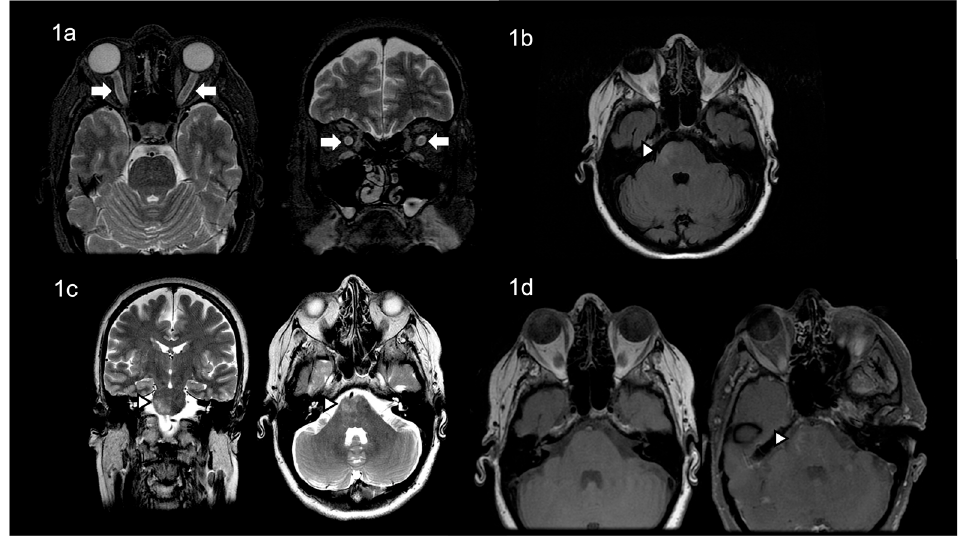
Figure 1. The patient’s brain MRI revealed, in T2 images, ( a ) mild thickening of the bilateral optic nerves, and ( b , c ) high-intensity lesions in the medial and right lateral pons, in T2/FLAIR images, ( d ) with contrast enhancement of the above lesions.